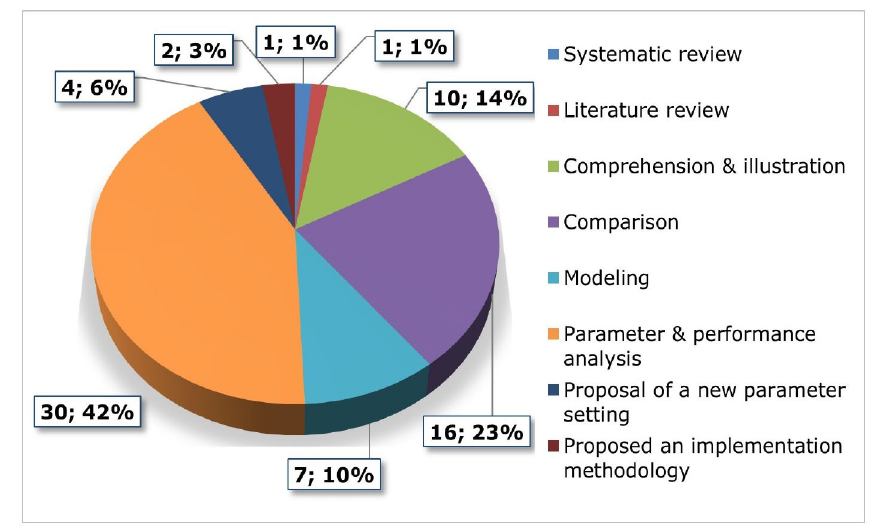
Figure 3. The main focus of research papers on DDMRP published in all